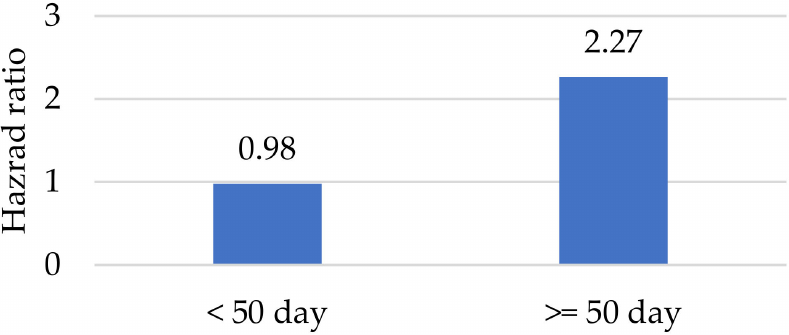
Figure 5. Hazard ratios—the intensity of the decline in share prices before and after day 50. Source: own elaboration on the basis of data from https://www.gpw.pl [73] (accessed on 19 June